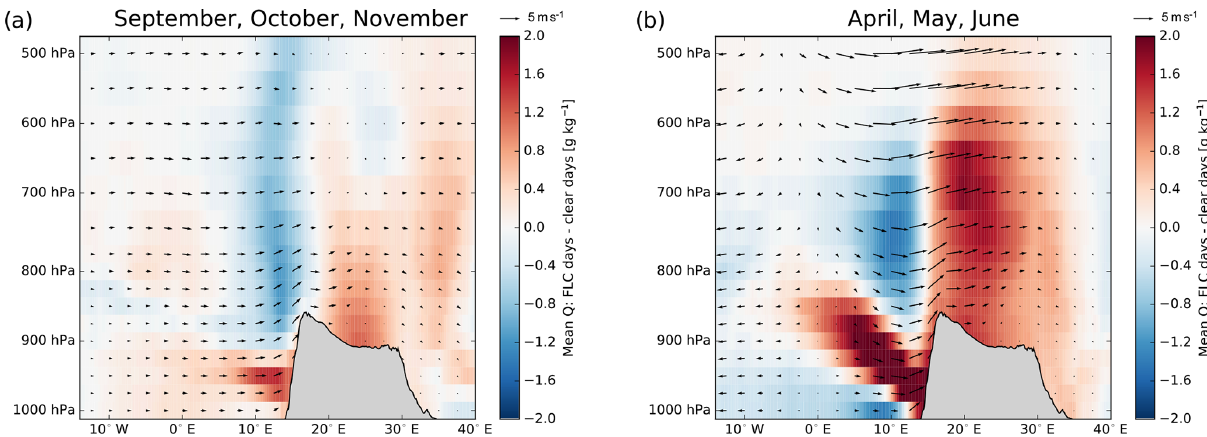
Figure 6. Seasonal average difference (FLC days − clear days) in specific humidity and u and w wind components at different pressure levels during (a) SON and (b) AMJ for the time period 2004–2017. Specific humidity and wind vectors are averaged between 20 and 25 ◦ S and shown at pressure levels between 1000hPa and 500hPa. For illustration purposes, the w vector is enhanced by a factor of 20. The masked grey area approximates the average surface elevation between 20 and 25 ◦